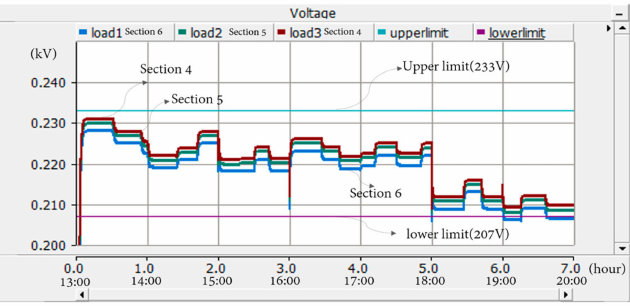
Figure 18. Analysis of the customer voltage characteristic by SVR operation (lower limit).